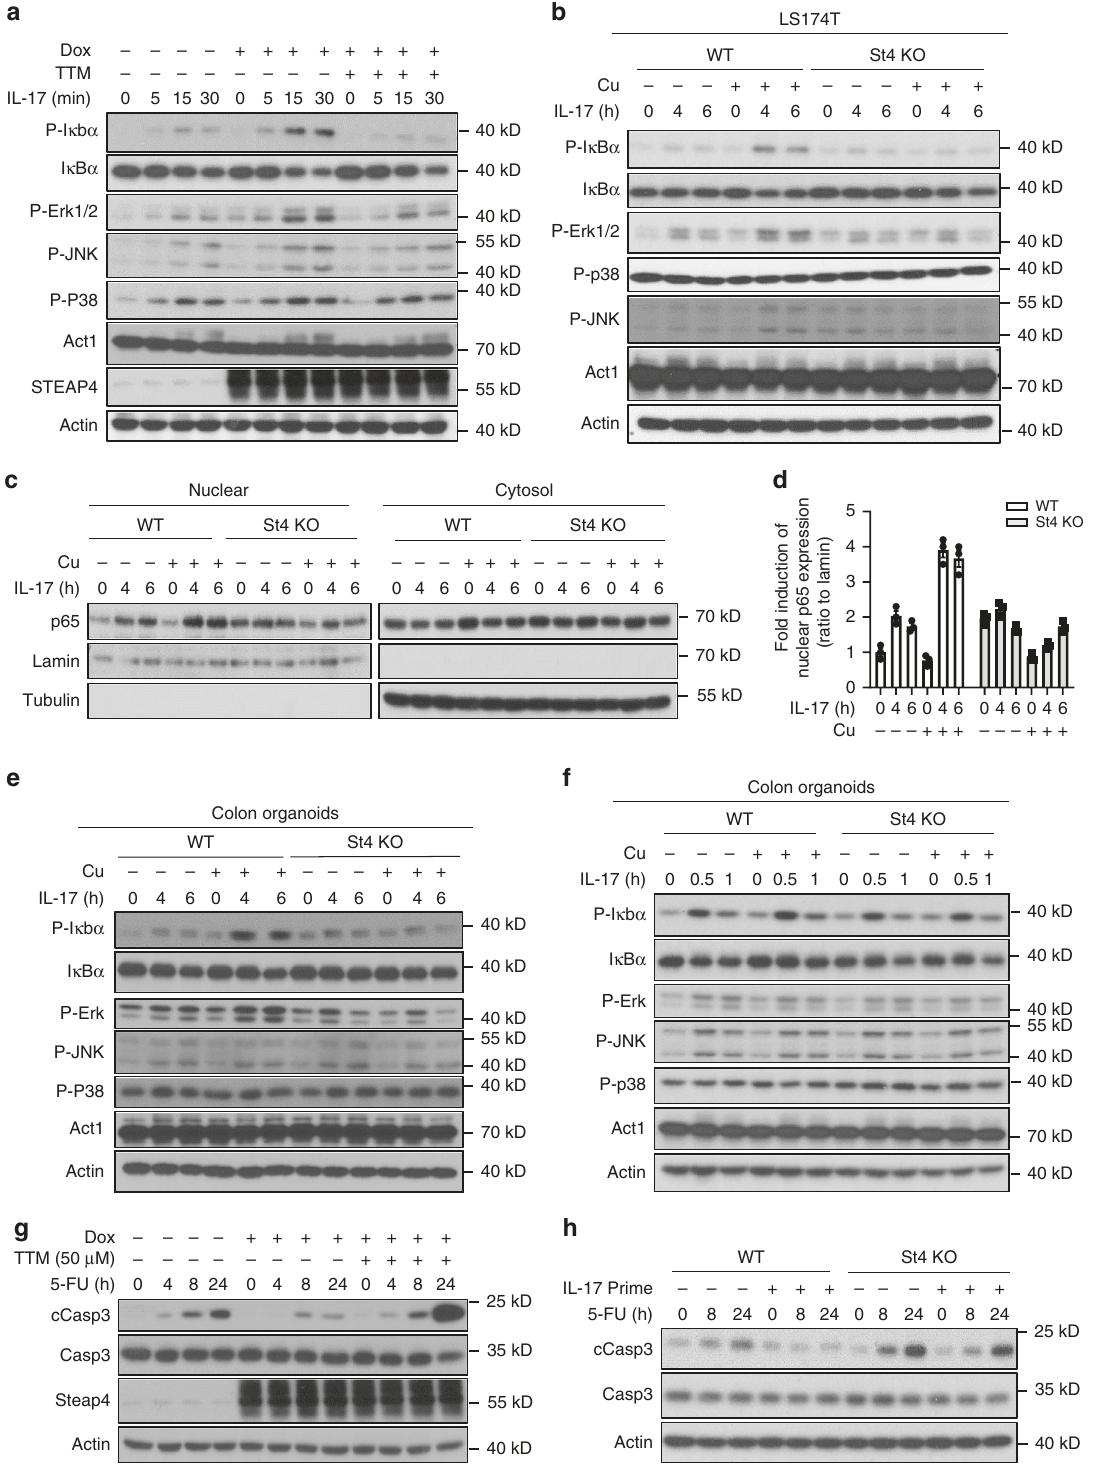
Fig. 3 Copper uptake mediated by STEAP4 sustains NF- κ B activation and inhibits apoptosis. a Western blot analysis of STEAP4-inducible Ls174t cells stimulated with IL-17 in the presence or absence of Dox and/or TTM. b Western blot analysis of wild-type (WT) and STEAP4 knockout (St4 KO) Ls174t cells stimulated with IL-17 for indicated hours in the presence or absence of 10 μ esCu(II). c Western blot analysis for nuclear translocation of p65 in the presence or absence of TTM under IL-17 treatment in WT and St4 KO Ls174t cells stimulated with IL-17 for indicated hours in the presence or absence of 10 μ abCu(II). d Densitometric quanti fi cation of ( c ). Error bar shows S.E.M. of quanti fi cation from three biologically independent cells. e , f Western blot analysis of primary colon organoids from wild-type (WT) or STEAP4 knockout (St4 KO) mice stimulated with IL-17 for indicated hours in the presence or absence of Cu(II). g Western blot analysis showed Steap4 overexpression inhibited apoptosis, which can be reversed by TTM. h 5-FU-induced cell apoptosis in Steap4 WT and KO organoids primed or unprimed with IL-17. Unless speci fi ed otherwise, data represent three independent experiments with similar